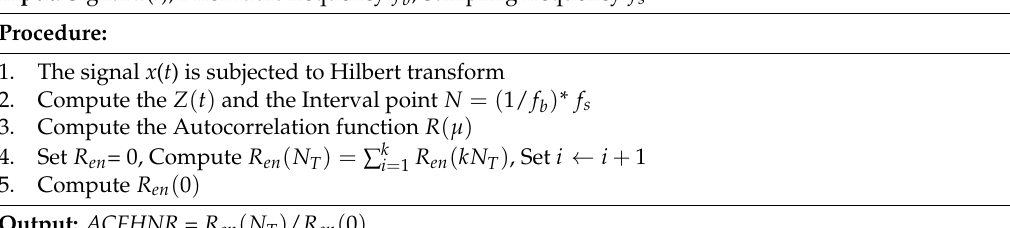
Table 1. The algorithm of the autocorrelation function impulse harmonic to noise ratio (ACFHNR) index.